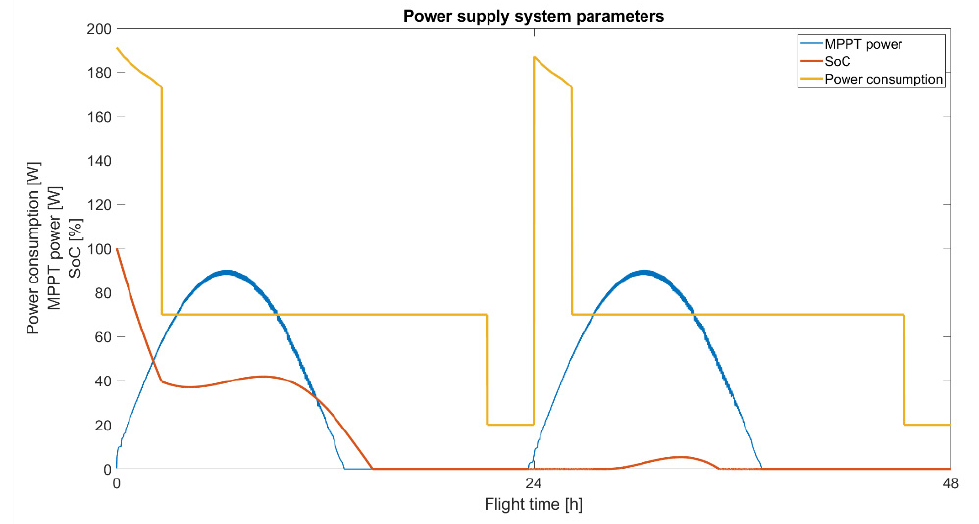
Figure 24. TwinStratos 17 5 km scenario in the vernal equinox.